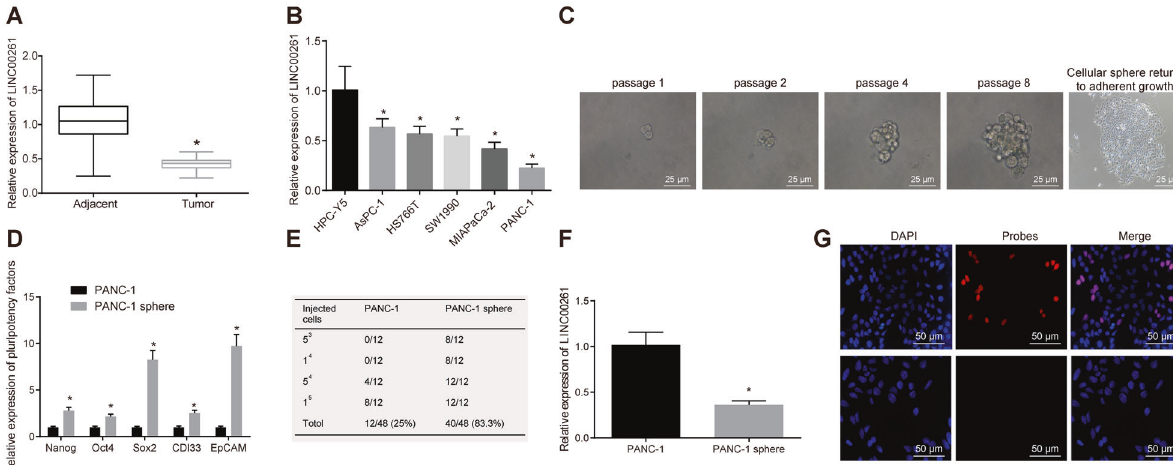
Fig. 2 LINC00261 is downregulated in veri fi ed PANC-1 stem cells. A The expression of LINC00261 in PC tissues ( n = 88) and adjacent normal tissues ( n = 88) determined by RT-qPCR. * p < 0.05 vs. the adjacent normal tissues. B The LINC00261 expression in PANC-1, AsPC-1, HS 766T, SW1990, MIA PaCa-2, and HPC-Y5 cell lines examined by RT-qPCR. * p < 0.05 vs. the HPC-Y5 cell line. C The enriched cell sphere in PANC-1 cells by suspension culture and the adherent cells after normal culture observed under the microscope (400×, scale bar = 25 µm). D Expression of surface molecular markers Nanog, Oct4, Sox2, CDl33, and EpCAM in PANC-1 cell sphere examined by RT-qPCR. * p < 0.05 vs. the PANC-1 cells. E The tumorigenicity of PANC-1 cells and PANC-1 stem cells in nude mice, n = 5. * p < 0.05 vs. the PANC-1 cells. F LINC00261 expression in PANC-1 cells and PANC-1 stem cells examined by RT-qPCR. * p < 0.05 vs. the PANC-1 cell. G Cellular location of LINC00261 in PANC-1 cells examined by RNA-FISH (200×, scale bar = 50 µm). Each experiment was repeated three times and measurement data were expressed as